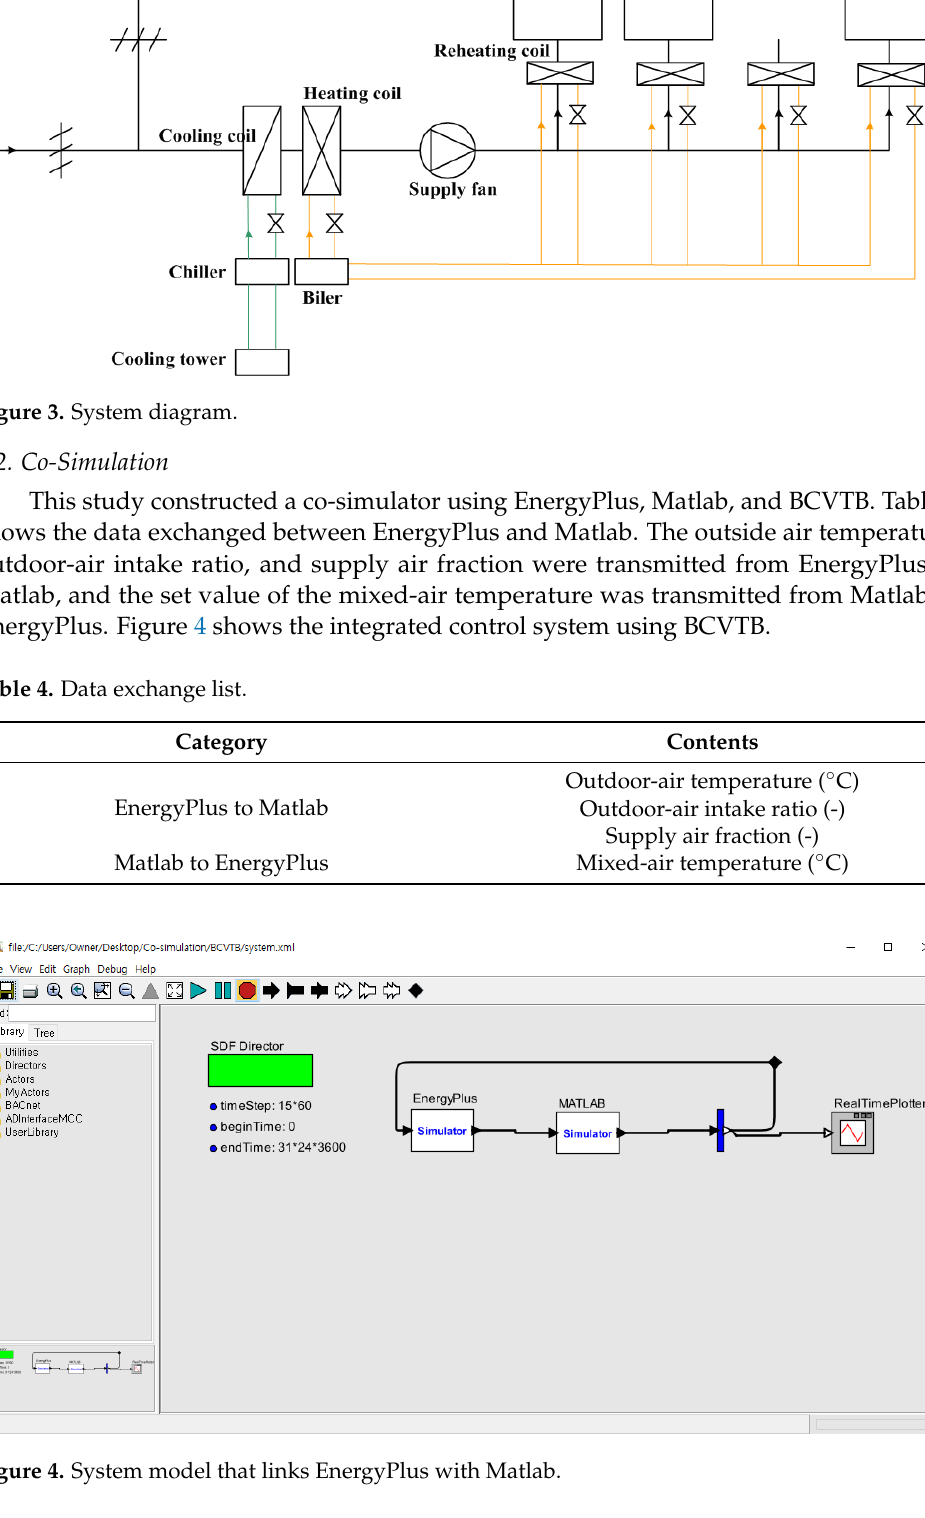
Figure 2. Internal heat gain schedules: ( a ) Occupancy; ( b ) Lighting; ( c ) Equipment.